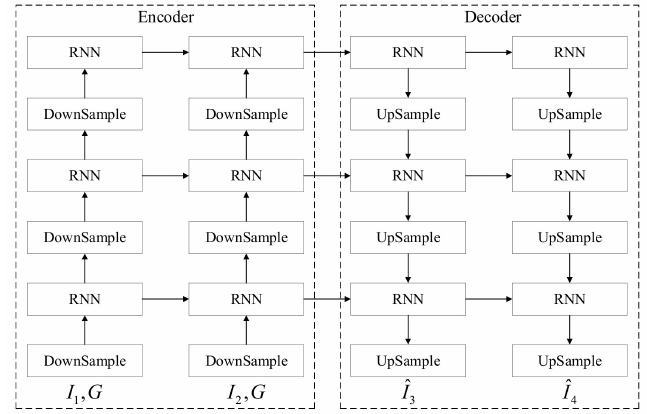
Figure 9. Schematic of the encoder-decoder